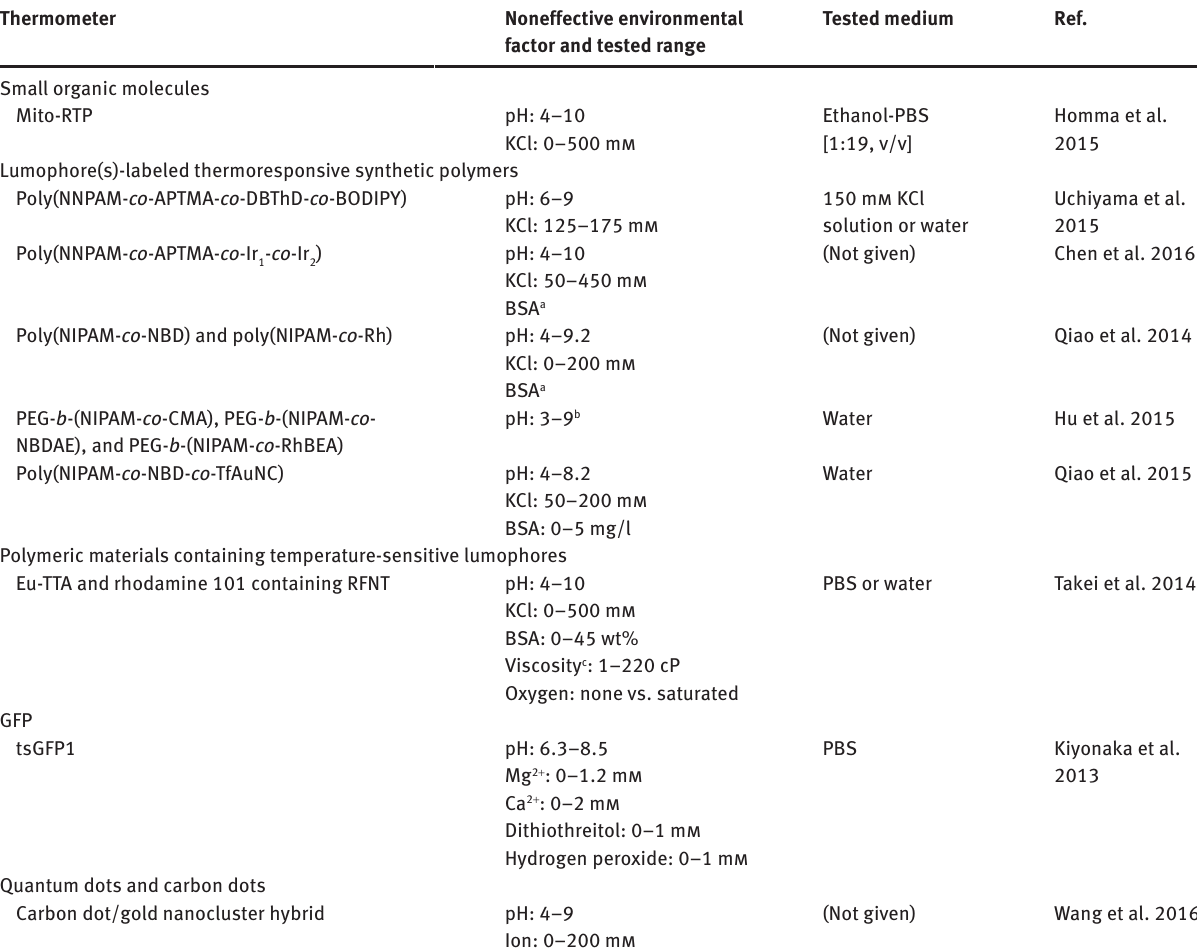
Table 2: Functional independence of the ratiometric luminescent molecular thermometers. Thermometer Noneffective environmental